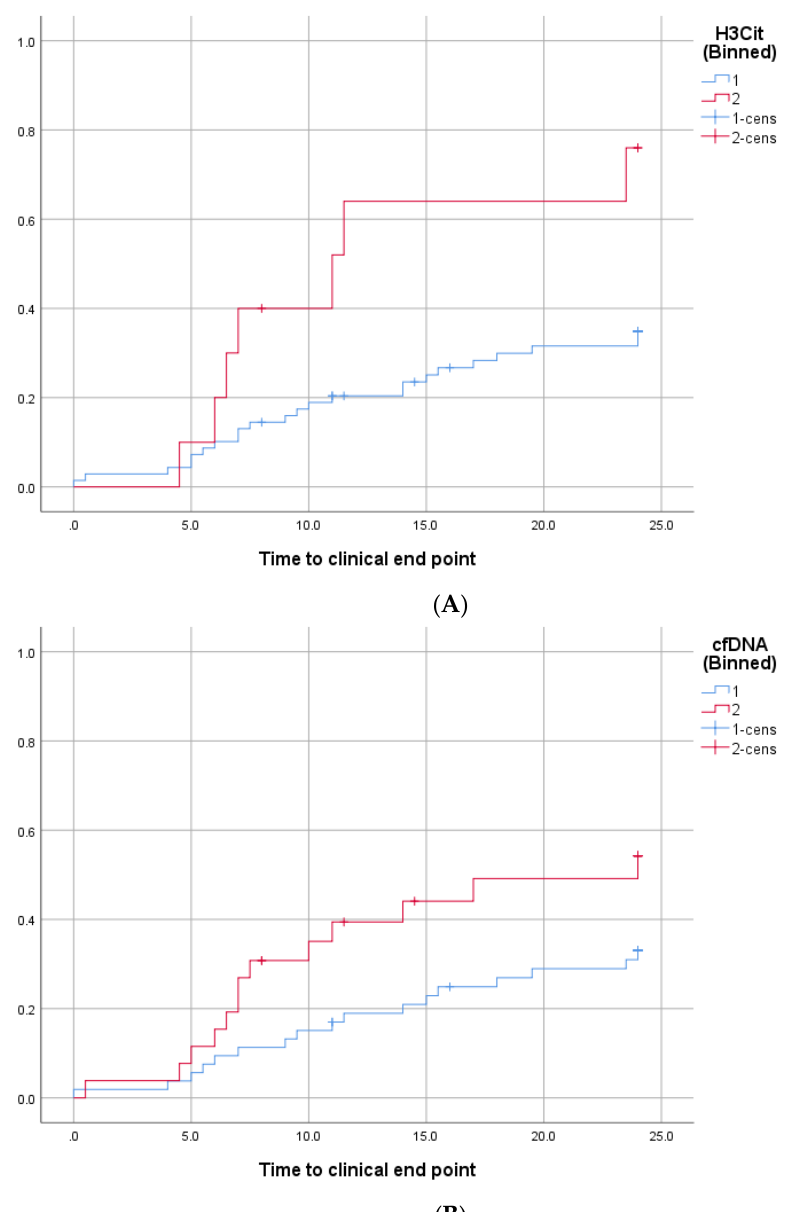
Figure 2. Cumulative incidence of adverse ischemic events according to circulating H3Cit ( A ) and cfDNA ( B ). Kaplan-Meier analyses for the cumulative incidence of adverse ischemic events (time to clinical endpoint) in patients with H3Cit ( A ) levels above or below the cut-off of 1128 ng/mL or cfDNA ( B ) levels above or below the cut-off of 605.9 ng/mL. The groups with circulating surrogate NET markers above the cut-off, who experienced primary endpoints, are indicated by red lines; blue lines indicate the groups with H3Cit or cfDNA levels below the cut-off.